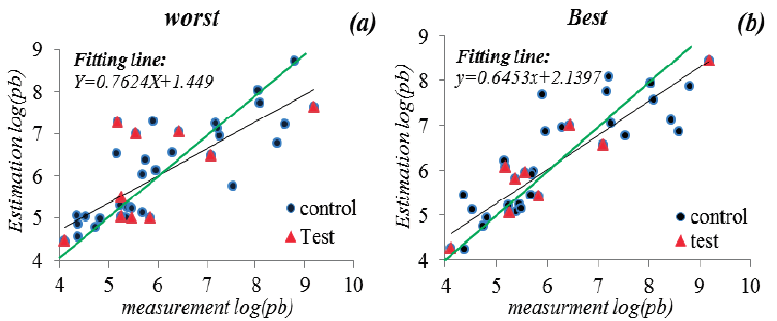
Figure 8. The scatterplot of estimated and expected the Pb concentration in the worst ( a ) and best ( b ) neural